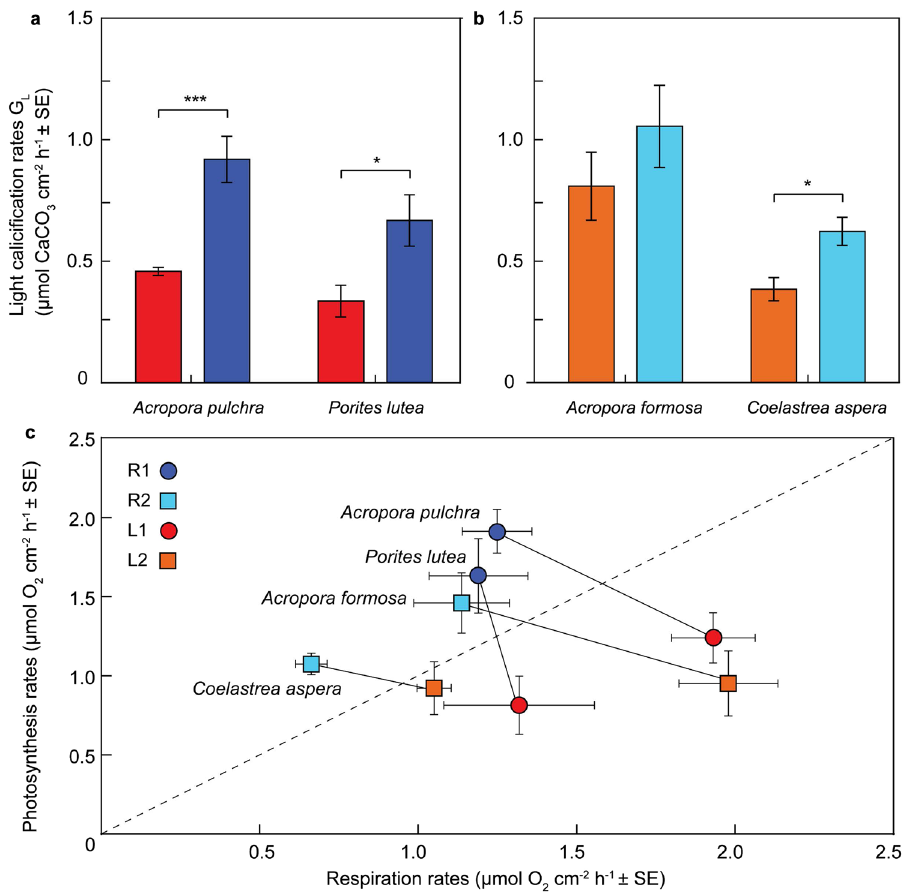
Figure 3. Coral metabolism in the Bouraké lagoon system versus reference reef sites. ( a , b ) Light-driven calcification (G L ) for Acropora pulchra and Porites lutea ( a ) at lagoon site L1 (red bars) and reference site R1 (dark blue bars), and Acropora formosa and Coelastrea aspera ( b ) at lagoon site L2 (orange bars) and reference site R2 (light blue bars). * p < 0.05, ** p < 0.01, *** p < 0.001 between groups according to t-test analysis ( n = 4 per species). ( c ) The metabolic comparisons of photosynthesis and respiration rates between reference sites R1, R2 versus lagoon sites L1, L2. Species-specific metabolic shifts are indicated by lines (black) and the dashed lines represent the 1:1